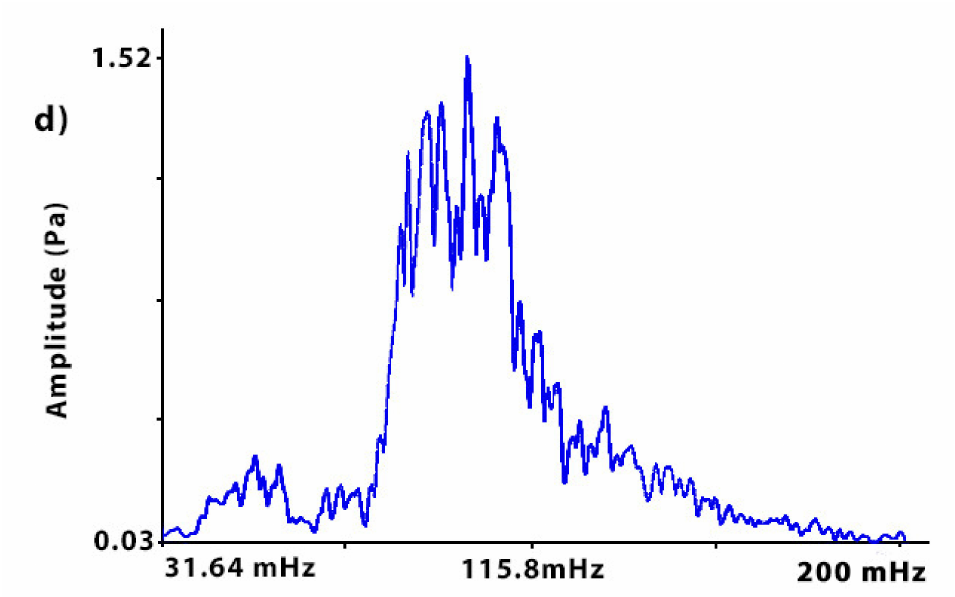
Figure 8. Dynamic spectrograms and spectra of laser strainmeter and laser meter of hydrosphere pressure variations records.